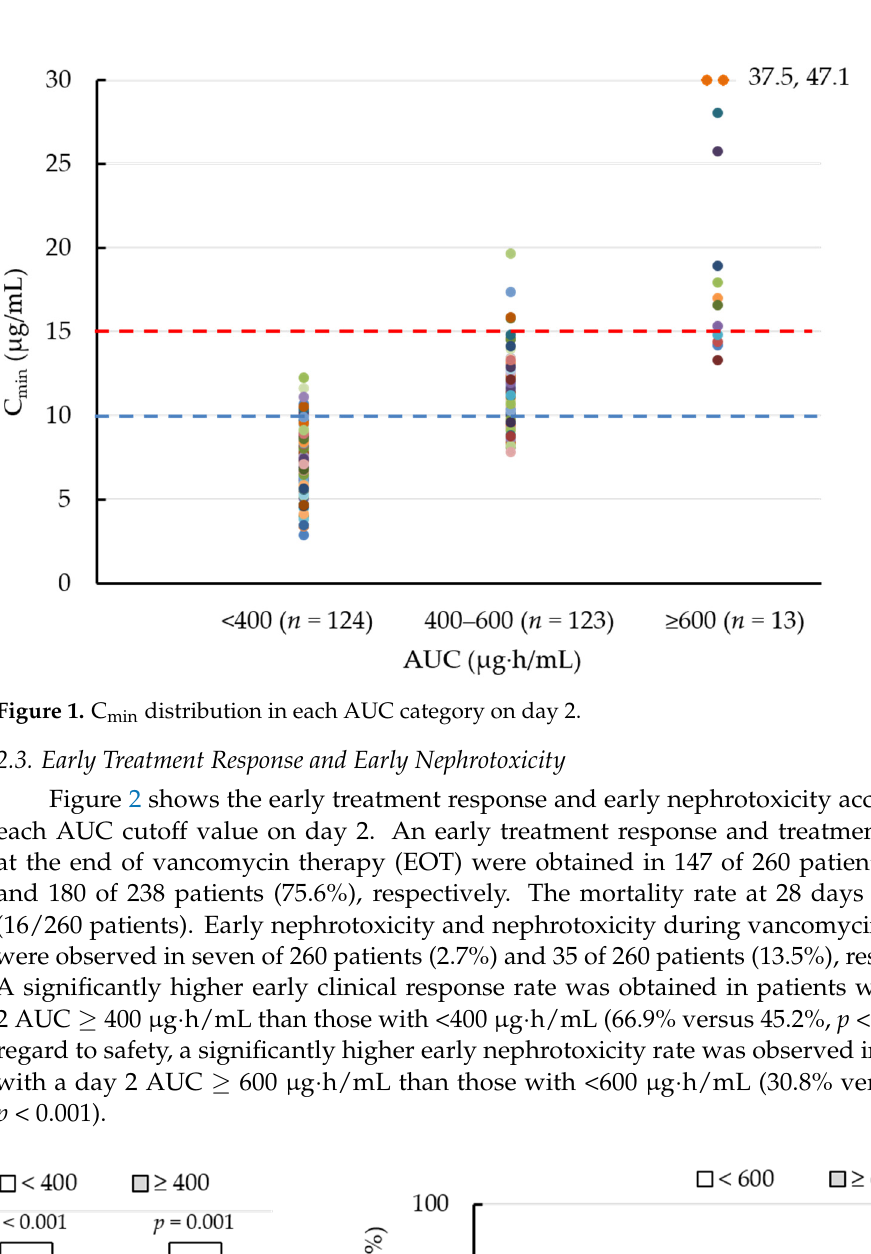
Table 2. Univariate and multivariate analyses of the potential variables affecting an early treatment response.